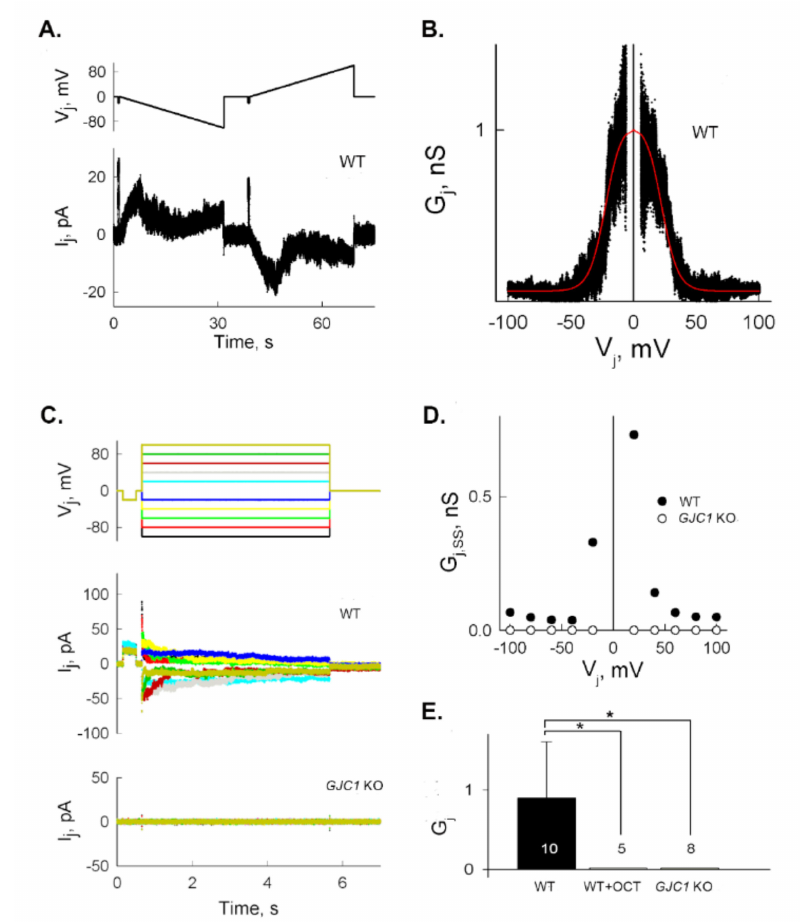
Figure 4. Electrical coupling and V j -gating are abolished by knocking out GJC1 (Cx45) in HeLa cells. ( A ) Example of macroscopic transjunctional currents (I j , bottom trace) recorded in response to long transjunctional voltage ramps (~3.5 mV / s) from 0 to + 100 and − 100 mV (V j , top trace) in a WT HeLa cell pair. ( B ) Junctional conductance dependence over transjunctional voltage (G j –V j plot), calculated from the record shown in (A). The red spline shows fitting with a two-state Boltzmann equation; parameters Vo = 21.8 mV and A = 0.153 mV − 1 . ( C ) Macroscopic transjunctional currents (I j ) in response to stepwise V j pulses from ± 20 to ± 100 mV, applied via 20-mV increments (top trace) to WT (middle trace) or GJC1 (Cx45) KO-HeLa (bottom trace) cell pairs. ( D ) Steady-state junctional conductance (G j,ss ) of WT (filled circles) and GJC1 (Cx45) KO-HeLa (open circles) cell pairs at di ff erent V j , calculated from records shown in C. ( E ) Average macroscopic G j measured at − 20 mV in WT HeLa cells (WT), WT HeLa cells treated with 1 mM octanol (WT + OCT), and GJC1 (Cx45) KO-HeLa cells ( GJC1 (Cx45) KO) are presented as bar graphs. Digits within each bar correspond to the number of independent